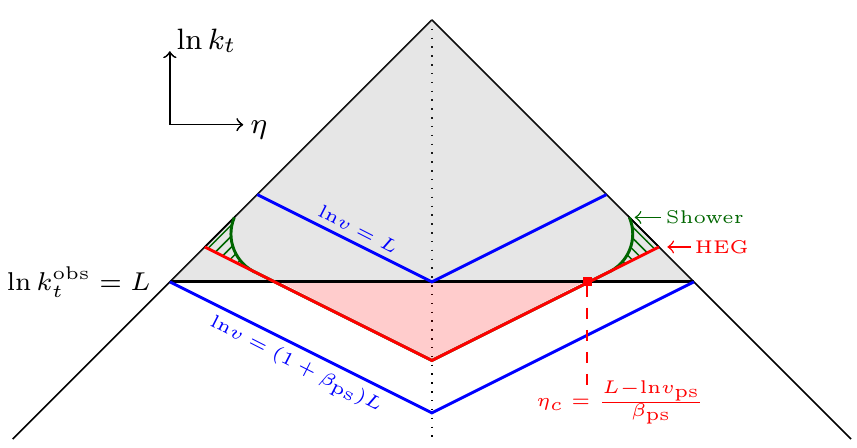
Figure 1. Lund plane [46] representation of the phase space for soft and/or collinear emission, and illustration of the interplay between a hardest emission generator (HEG), a parton shower and a constraint on an observable (black line). Dimensionful quantities ( k the centre-of-mass energy Q